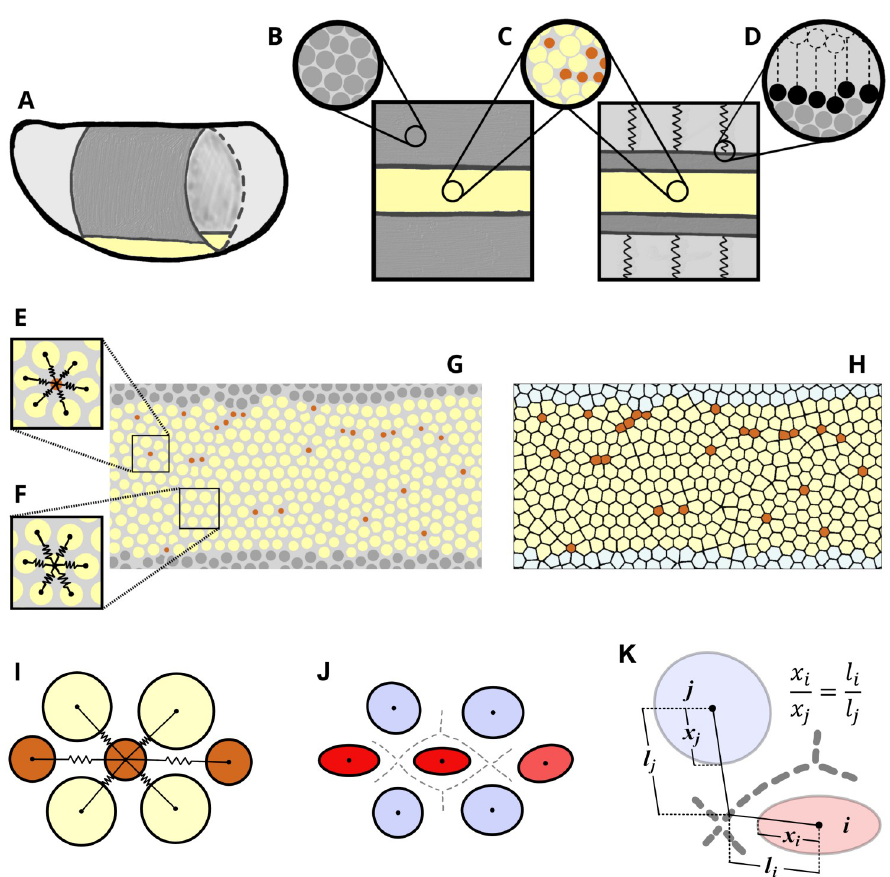
Fig 4. AGF model schematic. ( A ) The model represents the apical surface of the Drosophila embryo. The region of active cells that undergo apical constrictions during the initial phase of VFF in the mesoderm primordium is shown in yellow. Inactive cells in the lateral and dorsal regions (gray) do not experience constrictions. ( B,C ) Insets show how cells in both inactive (B) and active (C) regions are modeled as force centers represented by disks. ( D ) Inset shows how we implicitly model a portion of the inactive region as an effective elastic medium, in the interest of computational efficiency. ( E,F ) Cells interact with their adjacent neighbors through isotropic pairwise elastic potentials. Cells maintain the same neighbors even after constriction (constricted cells are marked in brown). ( G,H ) Particle configuration can either be represented by circles denoting force centers (G) or by Voronoi cells (H) generated using an anisotropic distance function. ( I,J ) The isotropic pairwise elastic potentials (I) are used to calculate the normalized virial stress tensor (Eq 10). A combination of an isotropic tensor (undeformed cell) and the virial stress tensor is used to define ellipses (J) representing a cell’s degree of deformation (Eq 9). The higher the eccentricity, the more anisotropic the deformation. The fill color shows tensile (red) and compressive (blue) major stresses. ( K ) Our augmented Voronoi tessellation establishes cell boundaries such that the ratio of distances from adjacent cell centers matches the ratio of center to edge distances of their representative ellipses.